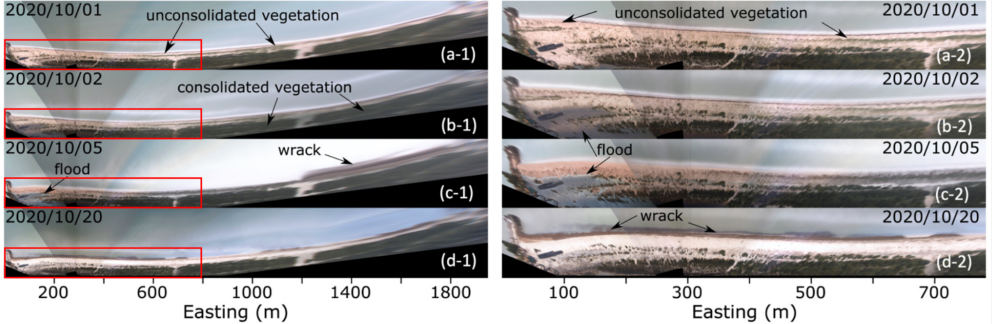
Figure 6. Rectified images from the video monitoring system showing a (1) 1950m and (2) 780m stretch of Sisal beach for (a) 1 Octo- ber 2020, (b) 2 October 2020, (c) 5 October 2020, and (d) 20 October 2020. Red boxes in (1) represent the area shown in (2). Images taken from http://tepeu.sisal.unam.mx/ (last access: November 2022).